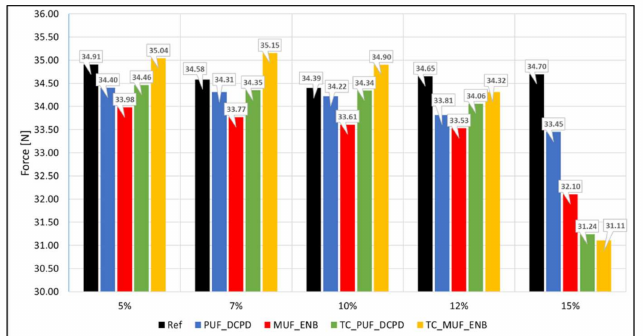
Figure 10. Impact strength with respect to microcapsule addition.